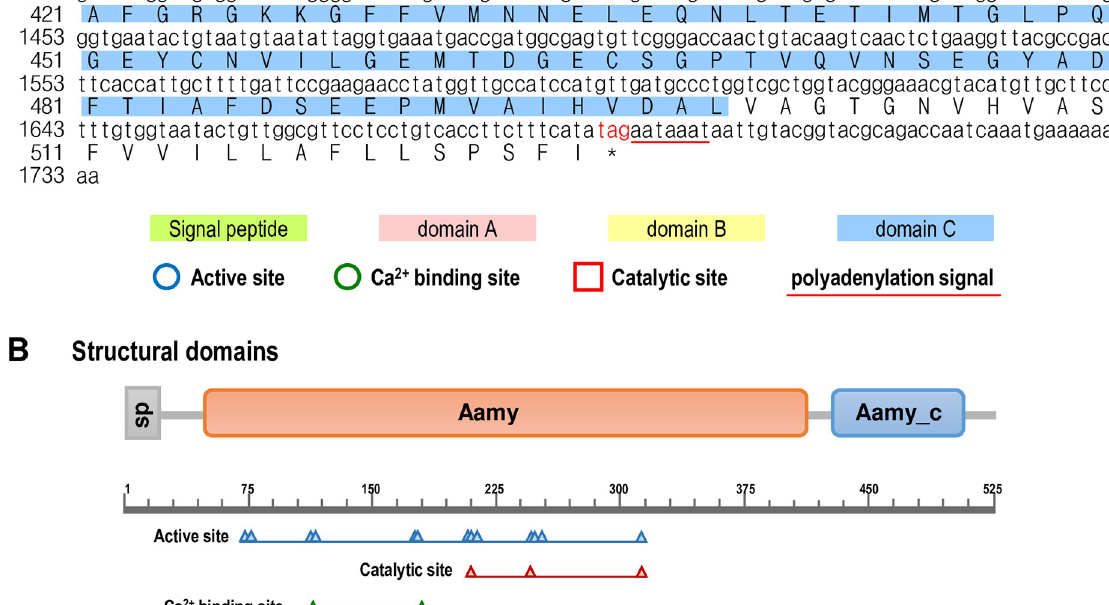
Fig 1. Full-length cDNA sequence and structural analysis of Hl-Amy. A : Full-length cDNA sequence and deduced amino acid sequence of Hl-Amy . The translational start codon (atg) and stop codon (taa) are shown in red, and the polyadenylation signal (aataaa) in the 3’-UTR is underlined. The signal peptide, domain A, domain B and domain C are shown in the boxes with different colors, and the active site, Ca 2+ binding site and catalytic site are indicated with different symbols. B : Structural domain of Hl-Amy predicted using the SMART, ScanProsite and BLAST programs. The signal peptide (SP), α -amylase domain (Aamy) and α -amylase C-terminal domain (Aamy_C) are boxed, and the active site, Ca 2+ binding site and catalytic site are